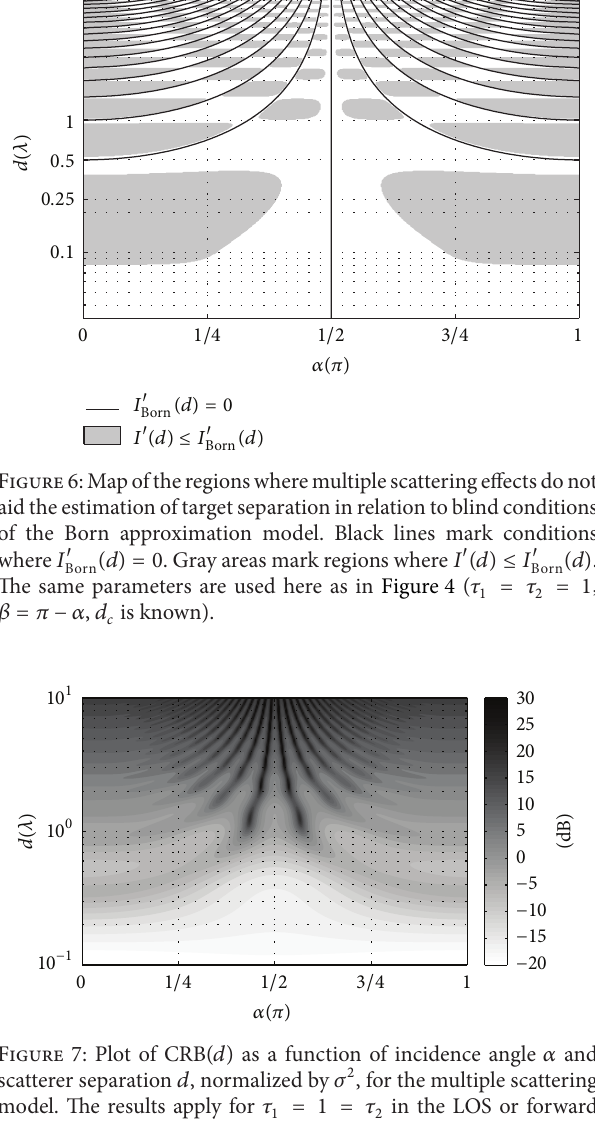
Figure 7: Plot of CRB (𝑑) as a function of incidence angle 𝛼 and scatterer separation 𝑑 , normalized by 𝜎 2 , for the multiple scattering model. The results apply for 𝜏 1 = 1 = 𝜏 2 in the LOS or forward scattering configuration, 𝛼 = 𝛽 .